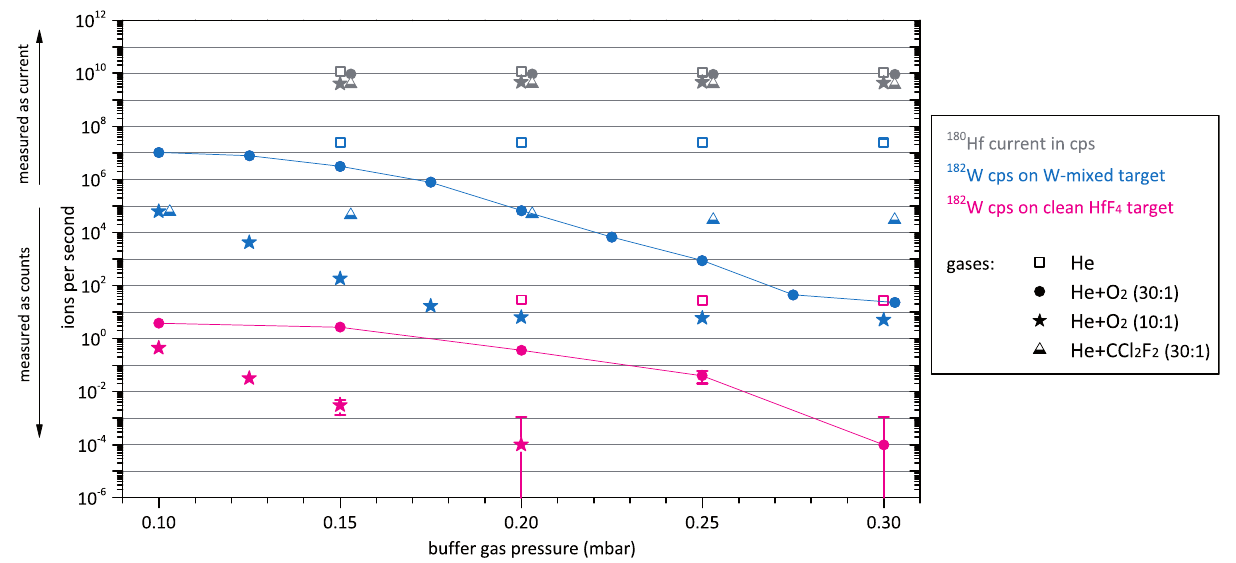
and 182 WF  transmitted through the ILIAMS cooler as a function of bu ↵ er gas pressure for Figure 1. Ion intensities of 180 HfF  5 5 various gases. The respective ion species were measured as 180 Hf 3 + and 182 W 3 + in a Faraday cup or an ionization chamber detector on the high-energy side of VERA. Plotted intensities are corrected for the e ↵ ective charge state yield of 20% (including accelerator transmission). Lines between symbols are to guide the